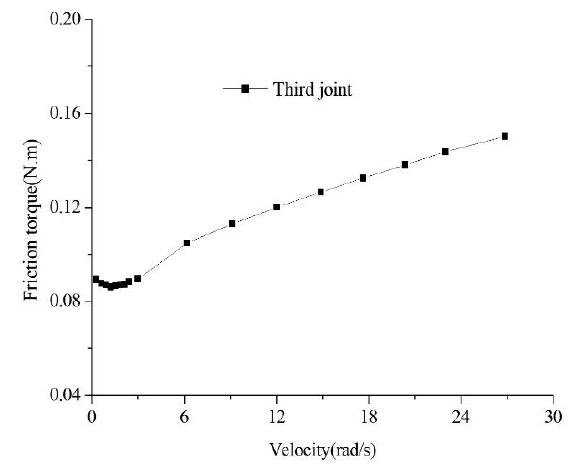
Figure 3. Friction torque of industrial robot.